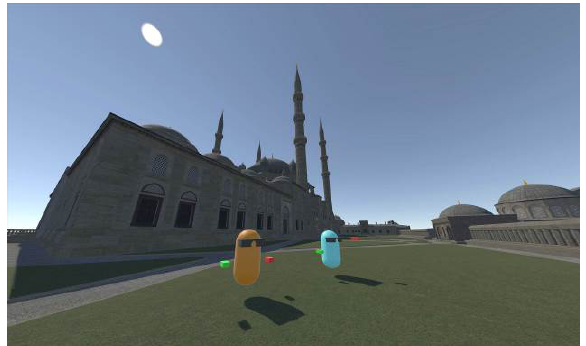
Fig. 13. Multi-user feature of the Virtual Reality System HTC Vive presenting two avatars with